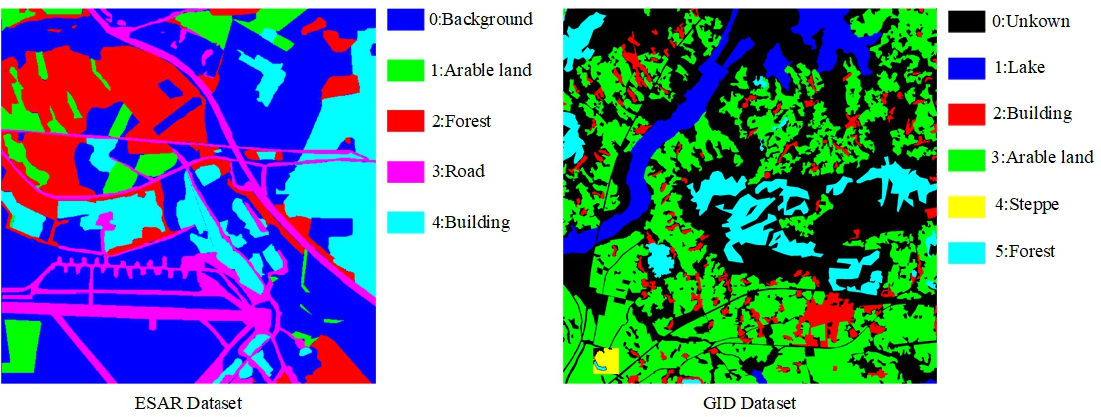
Figure 7. Categories of Two Datasets.